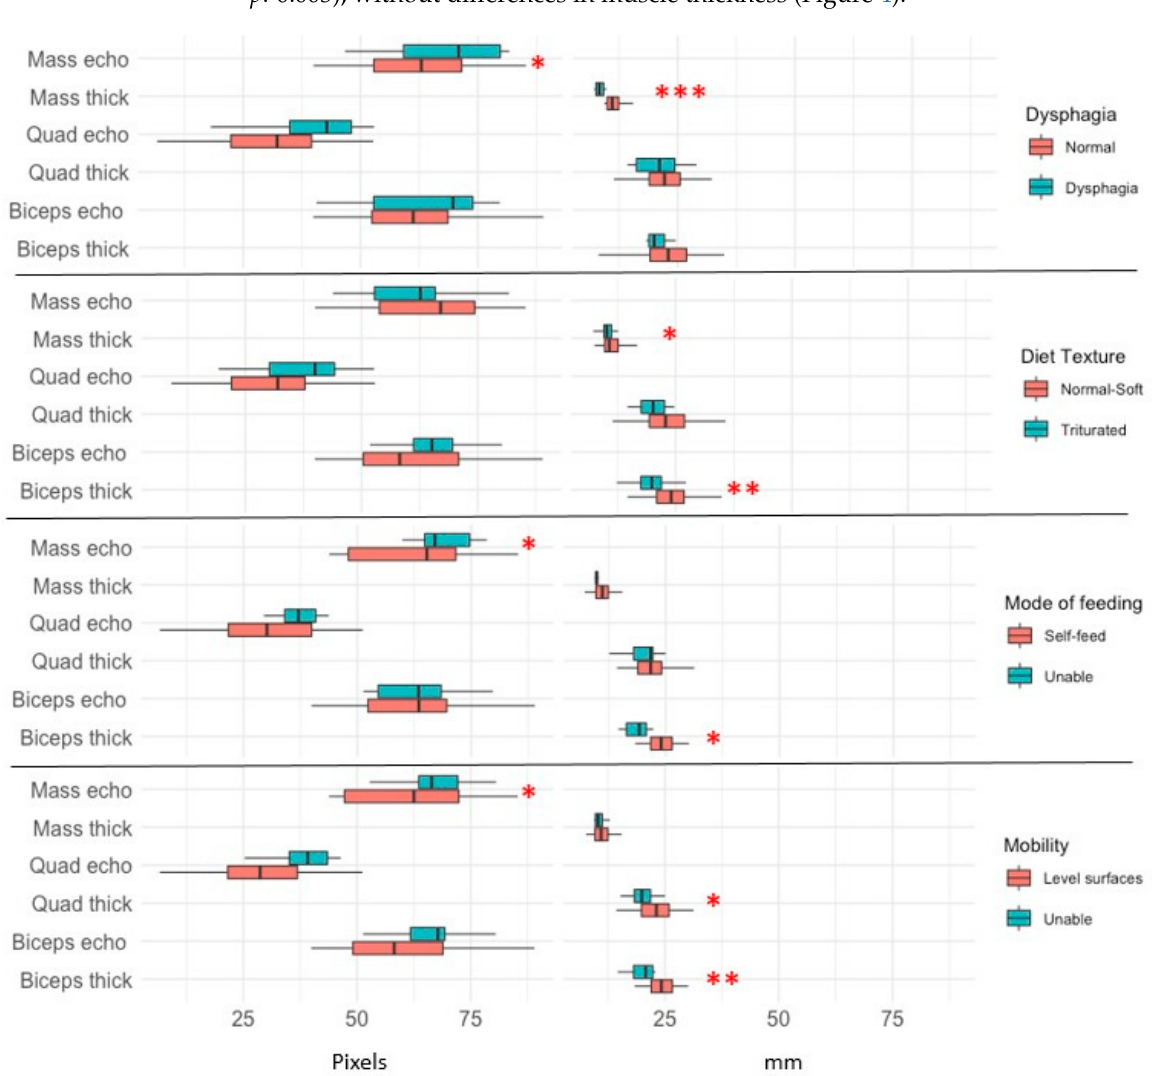
Figure 4. Comparison of muscle thickness and echogenicity of three muscles measured by ultrasound and functional assessment. Mass echo: masseter echogenicity, Mass thick: masseter thickness, Quad echo: quadriceps RF-VI echogenicity, Quad thick: quadriceps RF-VI thickness, Biceps echo: biceps brachii echogenicity, Biceps thick: biceps brachii thickness. * p < 0.05, ** p < 0.01, *** p < 0.001.